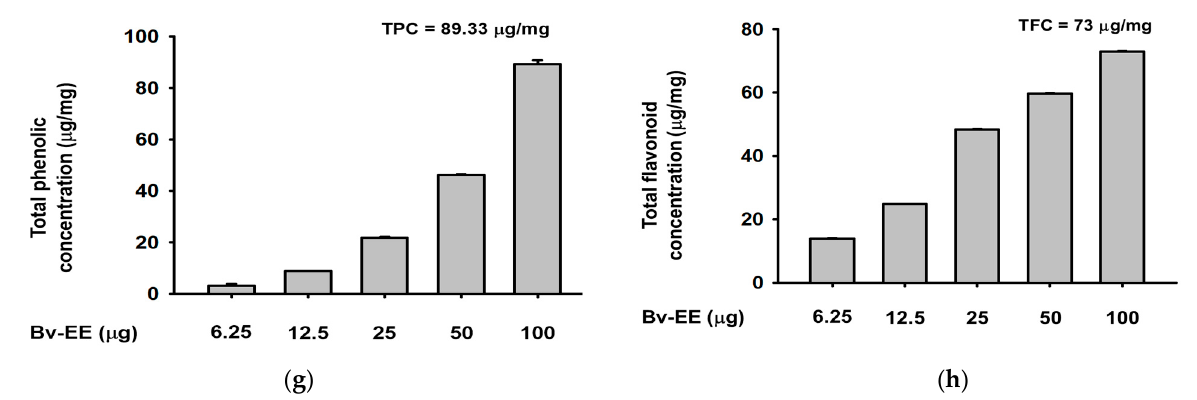
Figure 2. Bv-EE exerts ROS scavenging activity. The radial scavenging activity of Bv-EE was evaluated using the ( a ) DPPH and ( b ) ABTS assays. Ascorbic acid (300 µ M) was used as a positive control. ( c , d ) The DPPH and ABTS IC 50 values of Bv-EE. The ability of Bv-EE to use the metal reduction principle was shown in the ( e ) FRAP and ( f ) CUPRAC assays. Trolox (3 mg/mL) was used as a positive control. ( g ) The total phenolic content of Bv-EE expressed as mg of gallic acid equivalent/g of extract. ( h ) The total flavonoid content of Bv-EE expressed as mg of quercetin equivalent/g extract. All results are expressed as means ± standard deviations. ## p < 0.01 compared with the positive control group, and * p < 0.05, ** p < 0.01 compared with the normal group.